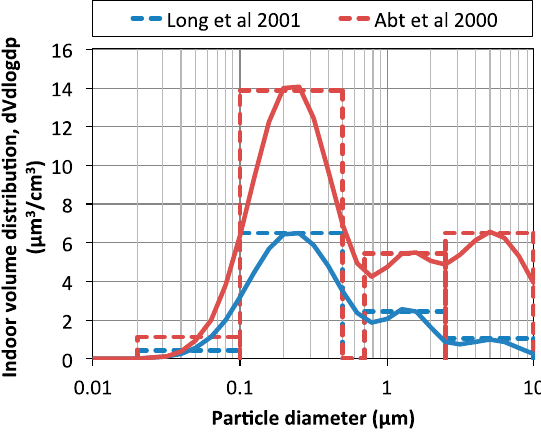
Figure 7. Residential indoor volume distributions for homes in Boston, Massachusetts (MA), in the United States (US) from Abt et al. (2000) [50] and Long et al. (2001) [51].